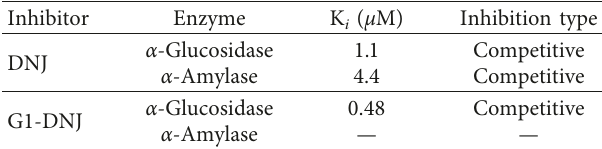
Figure S1: generation of the DNA construct for Bt α GTase expression. (A) The bt_2146 gene was amplified by poly- merase chain reaction (PCR). Lane S, DNA marker; lane 1, amplified Bt α GTase gene. (B) The pKTNd_bt2146 con- struct was generated by ligating bt_2146 into the pTKNd vector. Figure S2: Sodium dodecyl sulfate polyacrylamide gel electrophoresis (SDS-PAGE) of Bt α GTase at each pu- rification step. Lane S, protein size standards; lane 1, cel- lular protein from the crude extract; lane 2, soluble fraction;